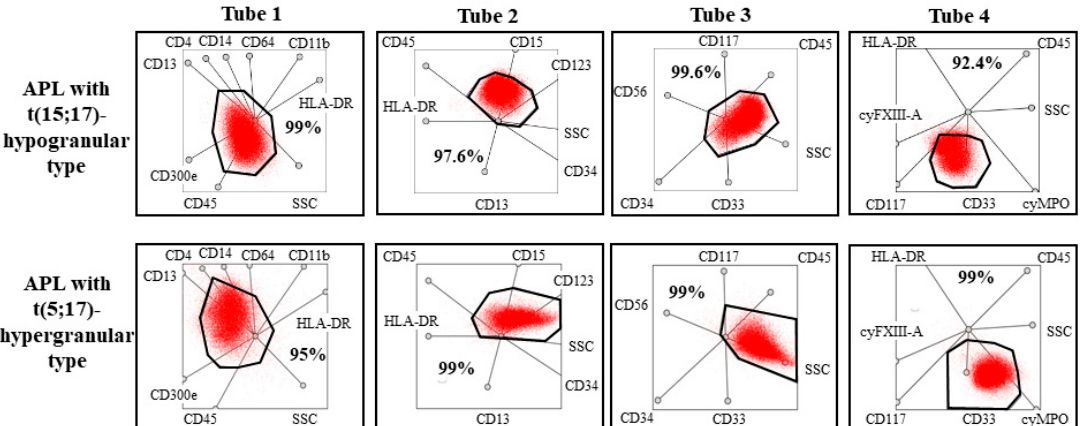
Figure 4. Multidimensional dot-plots of patients with APL. More than 95% of blasts were detected in the pre-defined gate in the cases of the two patients with classic and variant translocation of the RARA